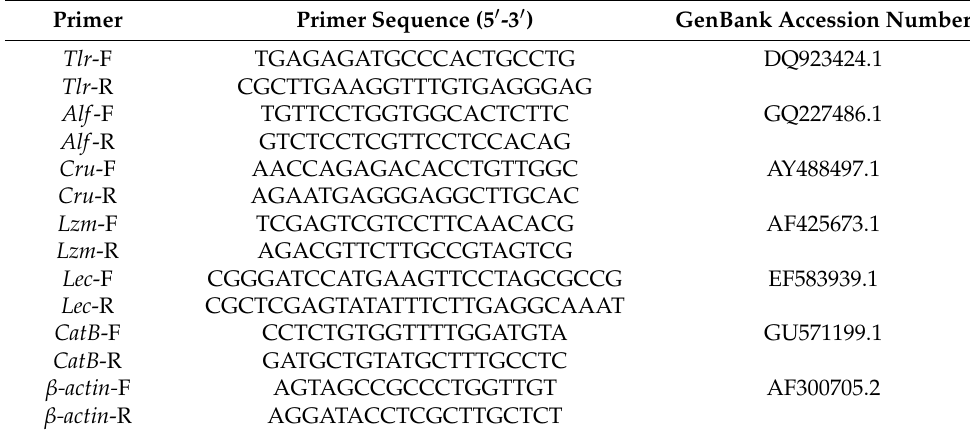
Table 2. Primer information for qPCR used in the